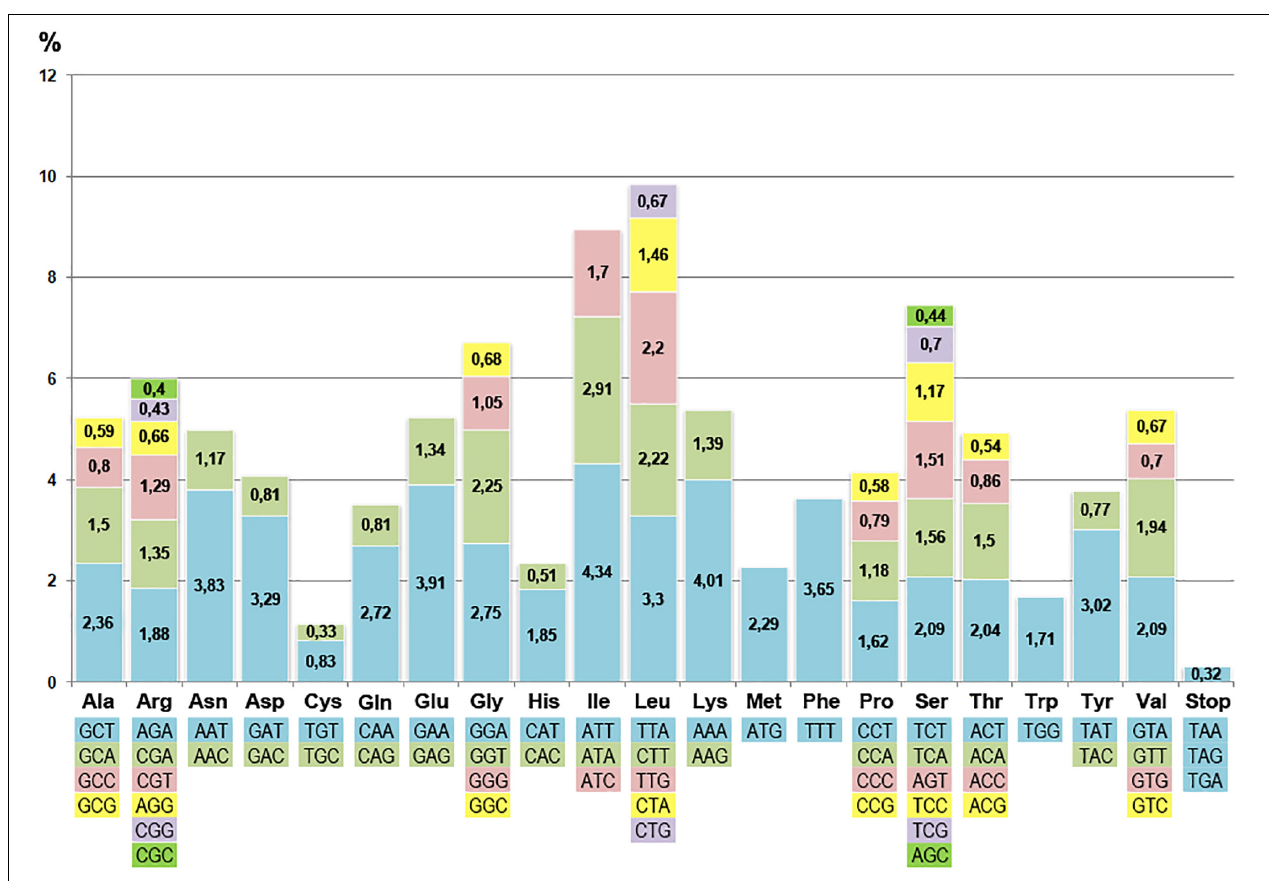
FIGURE 3 | Frequency of codons of various types in the coding sequences of curly birch